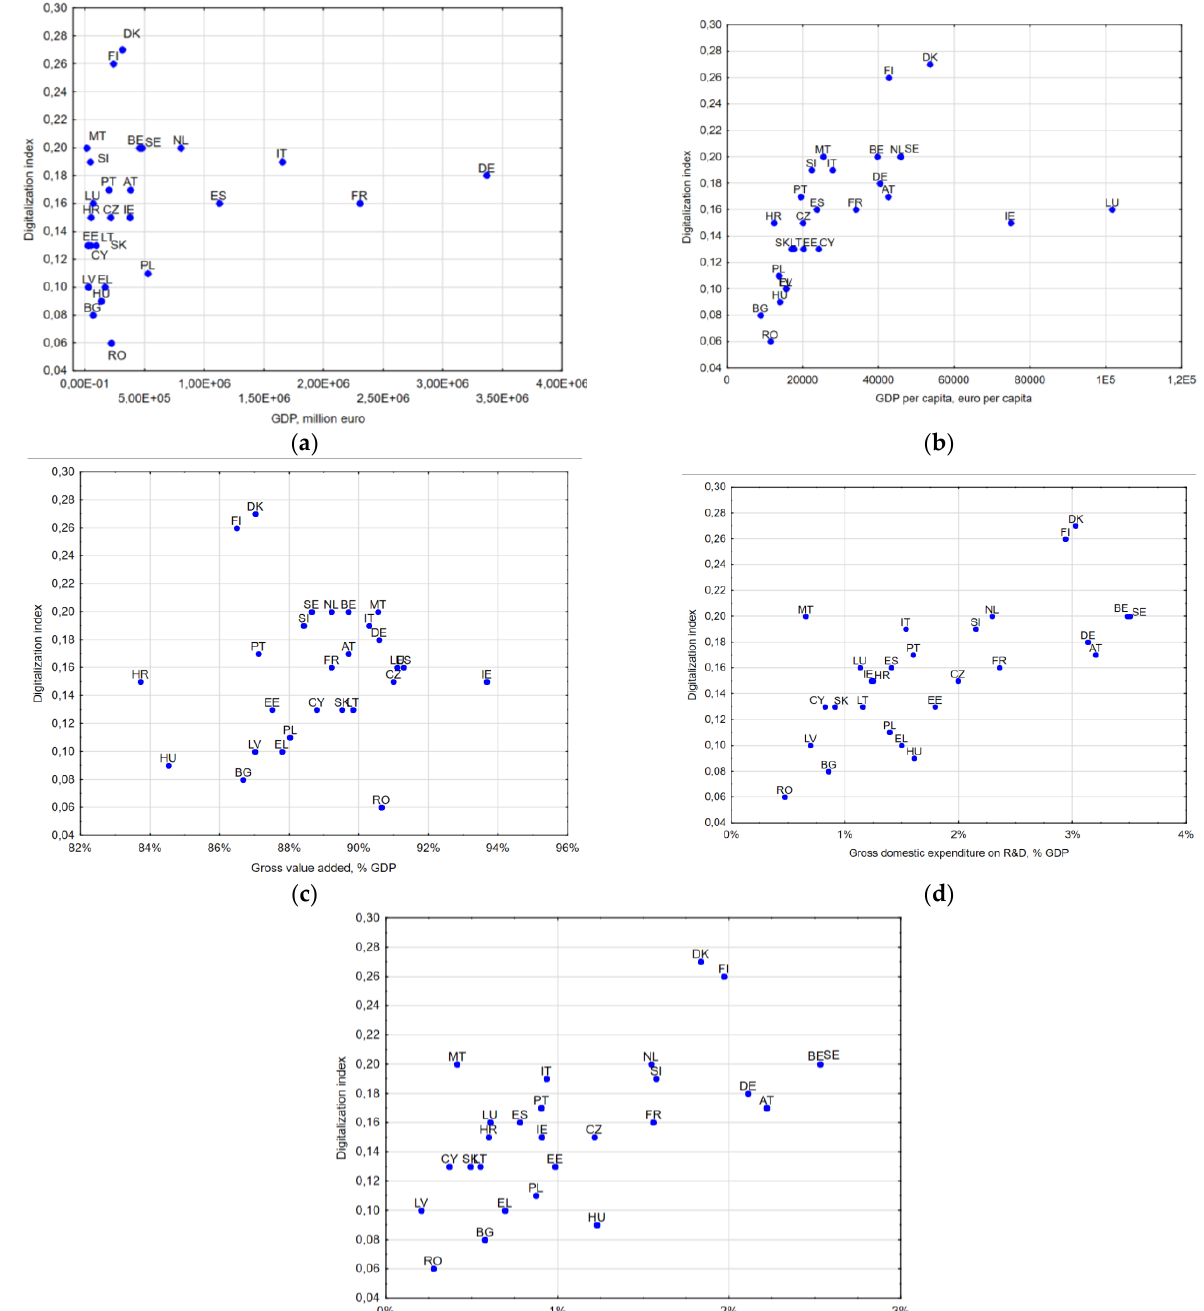
Figure 6. The relationships between the digitalization index values for individual EU-27 countries and their economic parameters (( a ) — Digitalization index vs. GDP; ( b ) — Digitalization index vs. GDP per capita; ( c ) — Digitalization index vs. gross value added; ( d ) — Digitalization index vs. Gross domestic expenditure on R&D; and ( e ) — Digitalization index vs. Business enterprise expenditure on R&D by NACE Rev. 2 activity).